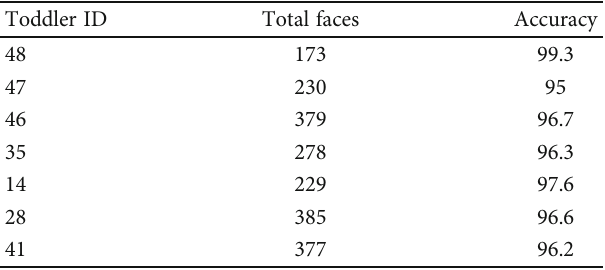
Table 1: Initial face recognition accuracy